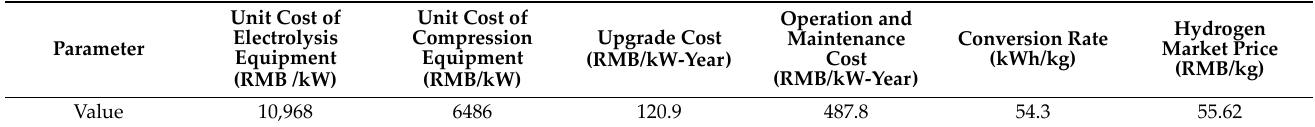
Table 1. Parameters of electrolysis hydrogen production